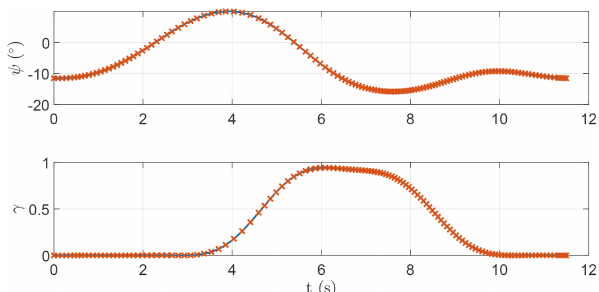
Figure B2. Time series of the control inputs provided to the harmonic balance method and the time integration scheme for a circular-shaped trajectory.